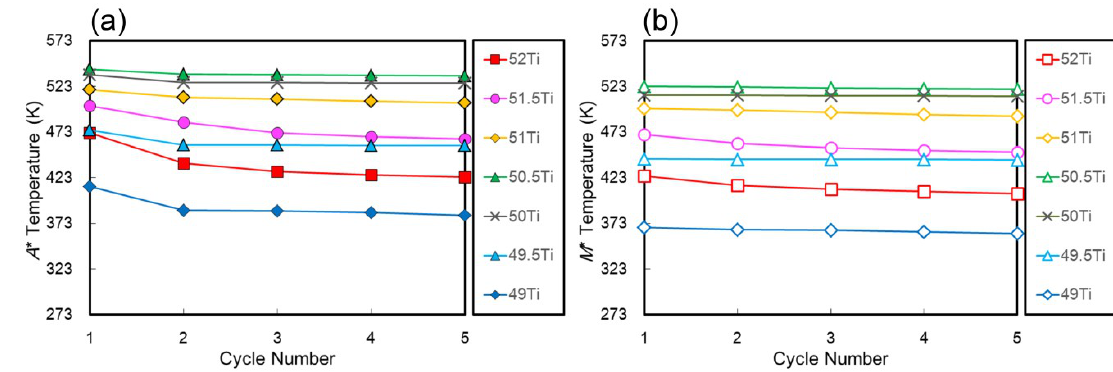
Figure 3. Change of transformation temperatures upon thermal cycling. ( a ) Reverse transformation peak temperature ( A* ) and ( b ) martensitic transformation peak temperature ( M* ).